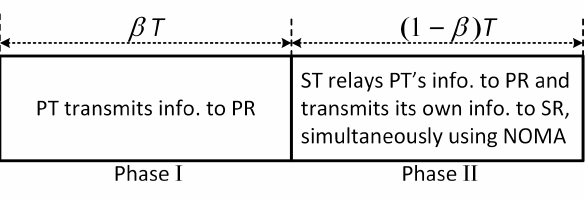
Figure 2. Time block of cooperative